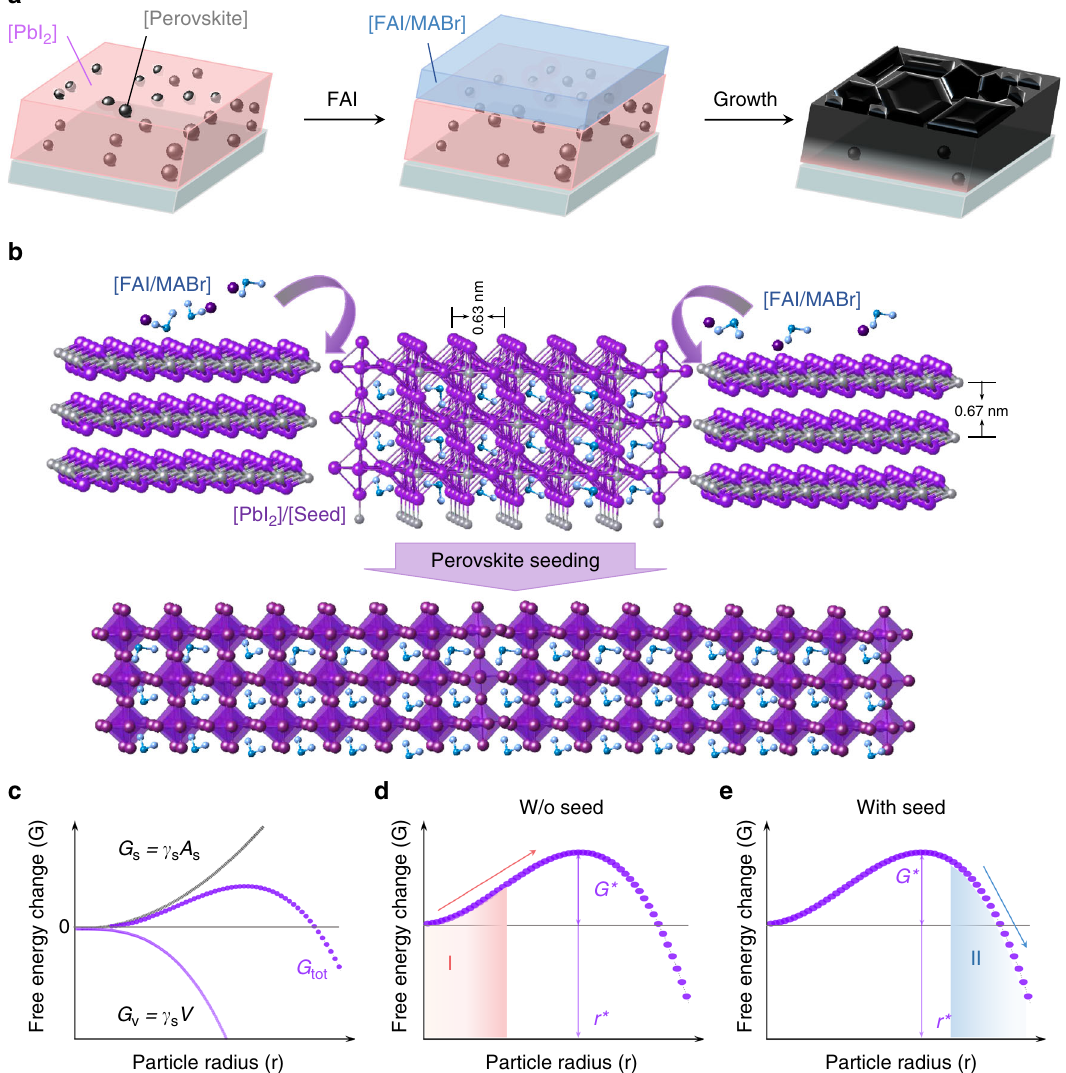
Fig. 1 Perovskite thin fi lms prepared by perovskite seeding growth. a Schematic of fabrication procedure of perovskite fi lms using perovskite seeding growth. b Schematic showing PbI 2 transformation to perovskite starting from perovskite seeds due to the lower energy barrier to perovskite crystallization. c The Gibbs energy G tot as a function of particle radius. G tot consists of a volume term G v and a surface term G s , where γ s and γ v are the surface free energy per unit area and volume free energy per unit volume, respectively; d – e Evolution of G tot during the crystallization process without and with the seed crystal, respectively. In the absence of seed crystal, a nucleus must fi rst be formed, and the nucleus must then overcome the energy barrier G * to grow beyond the critical radius r * (Region I). In the case of perovskite seeds embedded in PbI 2 , the size of the seed crystal is already larger than r * and thus the crystallization commences spontaneously from the seed (Region